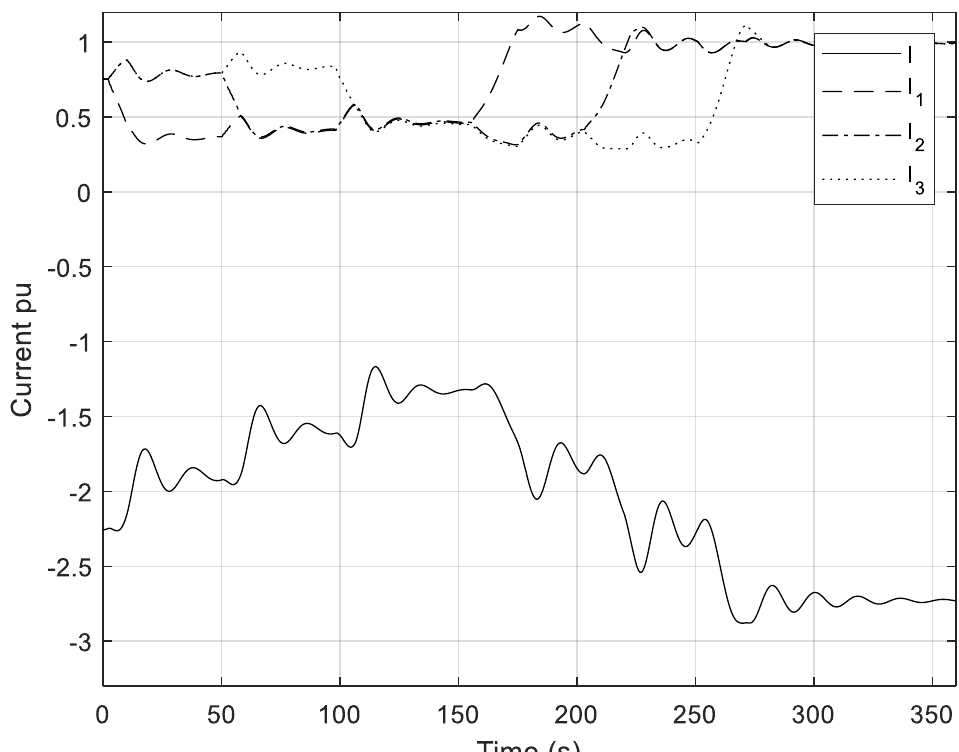
Figure 17. Deviations of rotor angles of PMSGs.